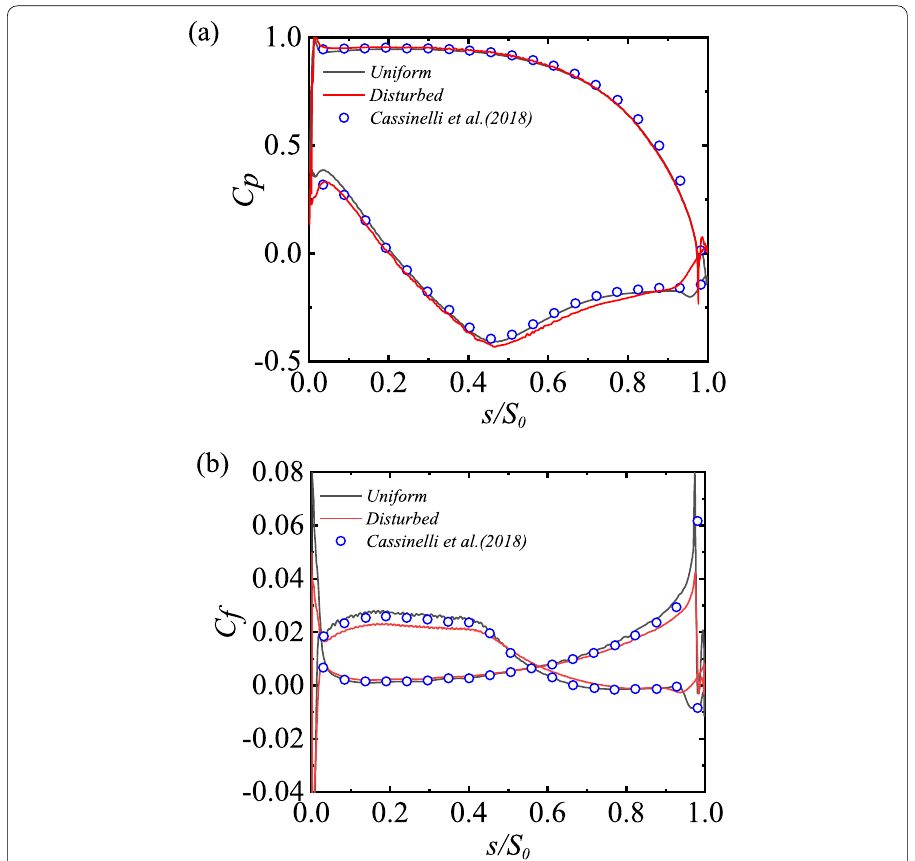
Fig. 3 The distribution of time- and spanwise-averaged ( a ) static pressure coefficient and ( b ) surface friction